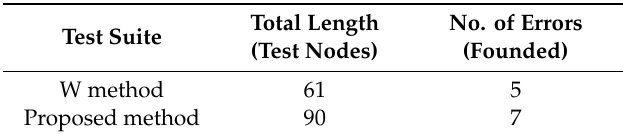
Table 8. Test results.